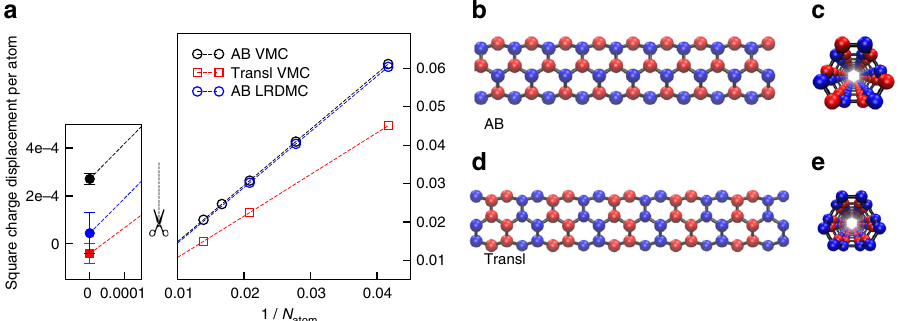
Fig. 4 Broken symmetry of the ground state from quantum Monte Carlo. a The square of the charge displacement per atom (empty circles and squares for “ AB ” and “ Transl ” order parameters, respectively) is plotted vs the inverse of the number of atoms, N atom , as obtained by variational (VMC) and lattice- regularized diffusion (LRDMC) quantum Monte Carlo. The fi lled symbols are linear extrapolations to the N atom = ∞ limit. The error bars are estimated by means of the jackknife method using more than 30 independent samples for each independent twist (Methods). The error bars of empty symbols are not visible on the scale of the plot. b – e The sketches of the tube illustrate the two possible broken symmetries, with the blue/red color pointing to the de fi cit/ surplus of charge. The AB order parameter, peculiar to the EI, is a uniform charge displacement between the two carbon sublattices (panels b and c show respectively the lateral and cross-sectional views of the tube). The Transl parameter is a charge displacement between two adjacent unit cells, signaling a charge density wave order breaking the translational symmetry (panels d , e )